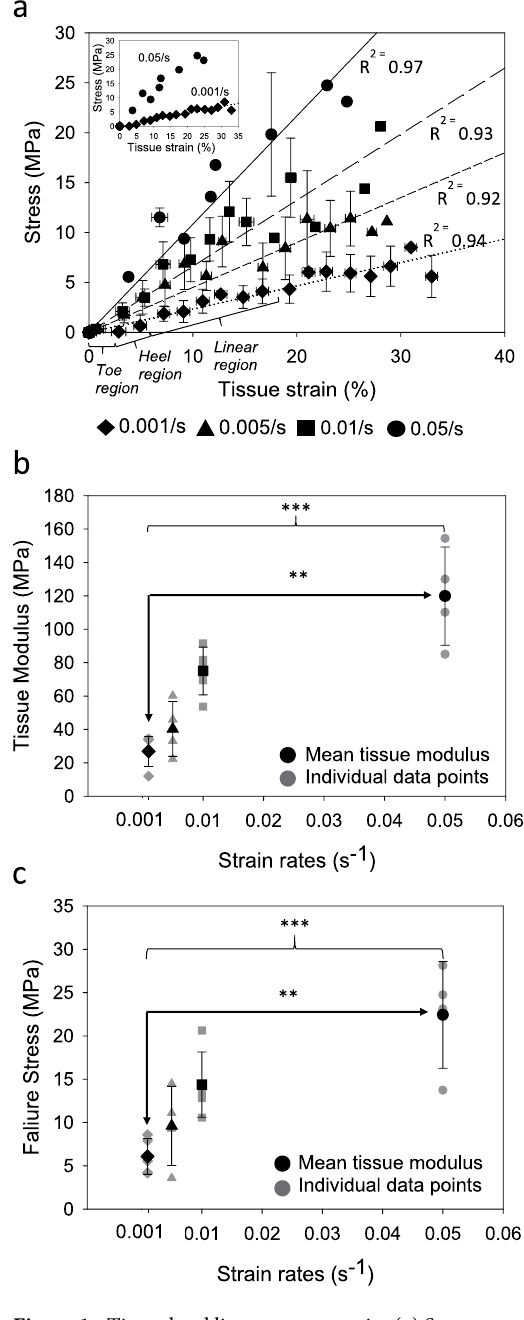
Figure 1. Tissue level ligament properties ( a ) Stress vs. measured tissue strain % (n = 5 for each strain rate, error bars are SD). Lines are linear regressions. Insert showing stress vs. measured tissue strain % for the slowest and fastest strain rates tested in this study. ( b ) Tissue modulus (individual data points and mean ± SD for n = 5) ( c ) Failure stress (individual data points and mean ± SD for n = 5). ( * p < 0.05, ** p < 0.01, *** p <